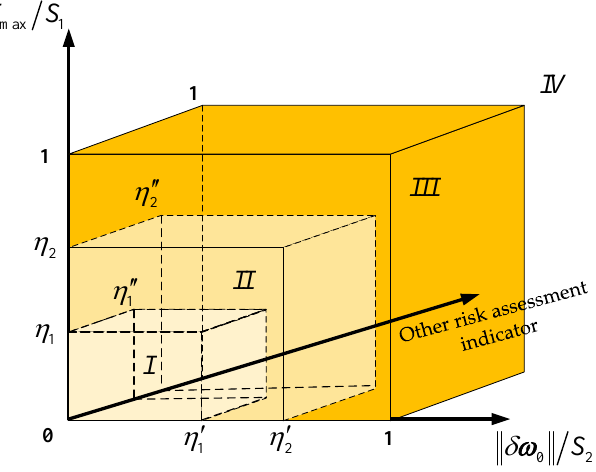
Figure 6. Three-dimensional risk assessment space.